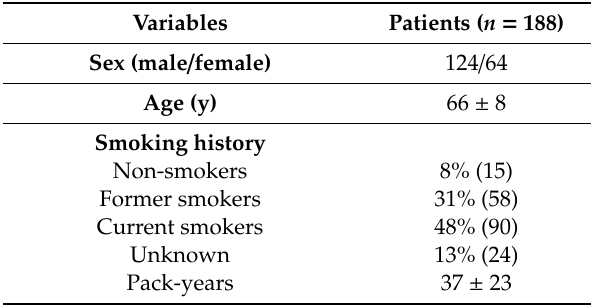
Table A1. Characteristics of the study